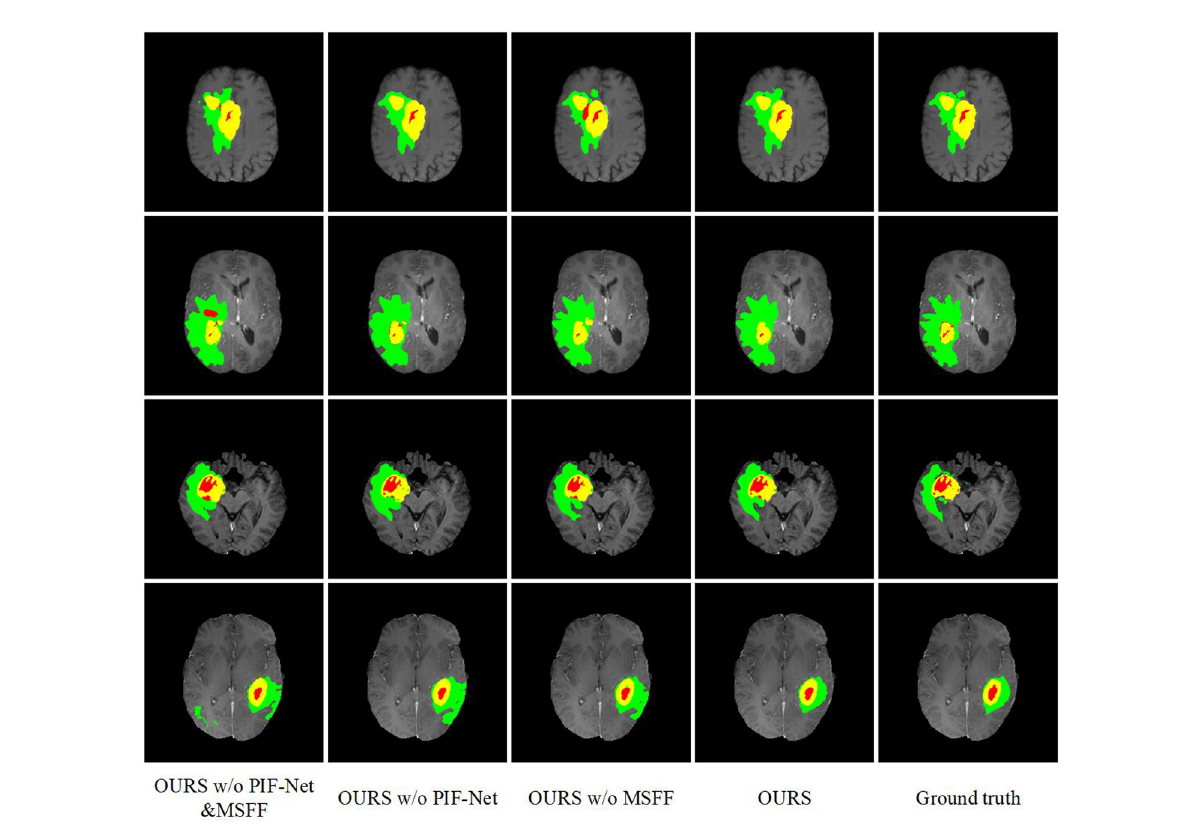
FIGURE7 Examples of brain tumor segmentation results obtained by di3fferent methods in the ablation study. The green, red, and yellow regions indicate edema (ED), non-enhancing tumor and necrosis (NCR/NET), and enhancing tumor (ET),